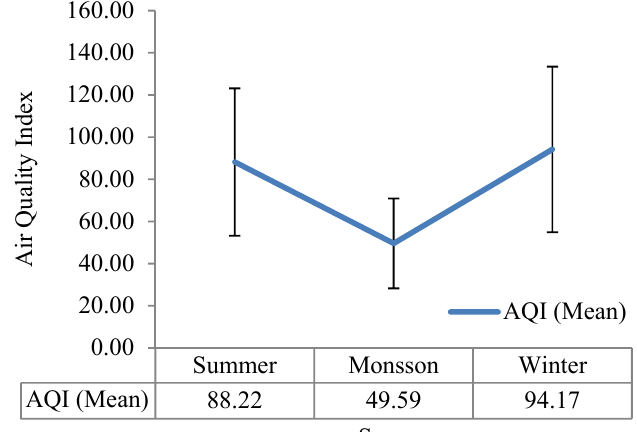
Fig. 3: Mean with standard deviation of AQI (Season Wise)